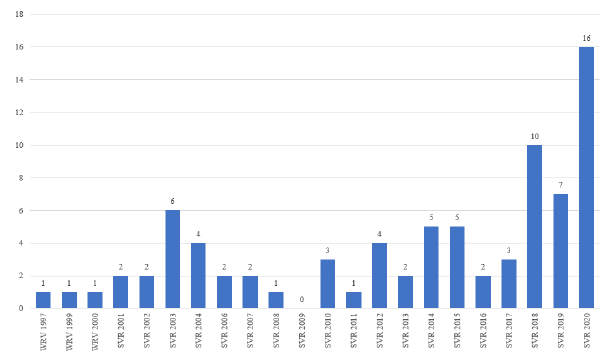
Figure 8. Overall distribution of papers from the “So- cial/economic/technical impacts of XR” topic.